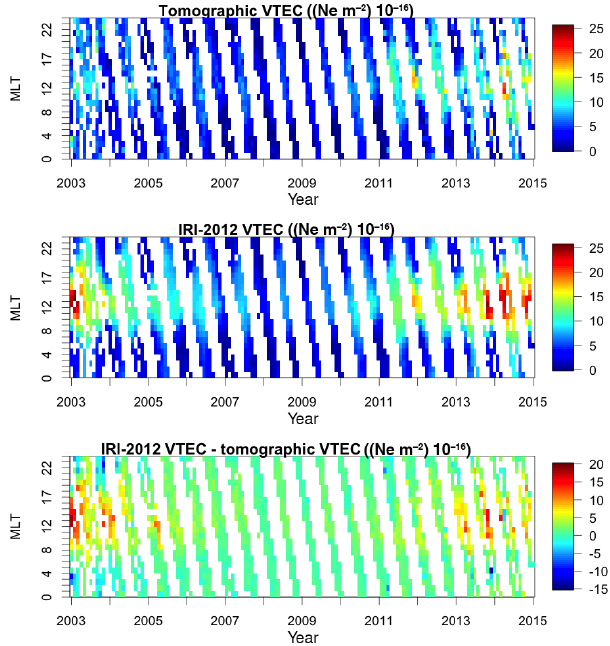
Figure 9. Monthly VTEC averages for each MLT hour over the Kokkola